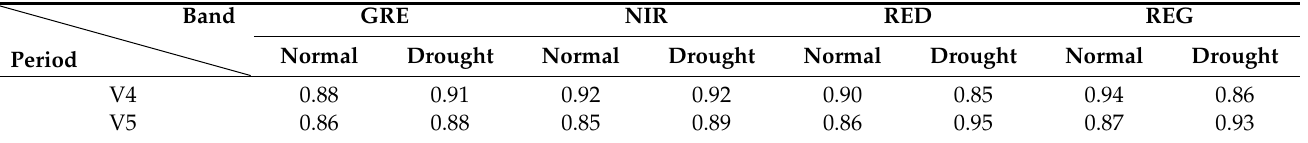
Table 11. Correlation analysis between the soybean wilting index and average leaf